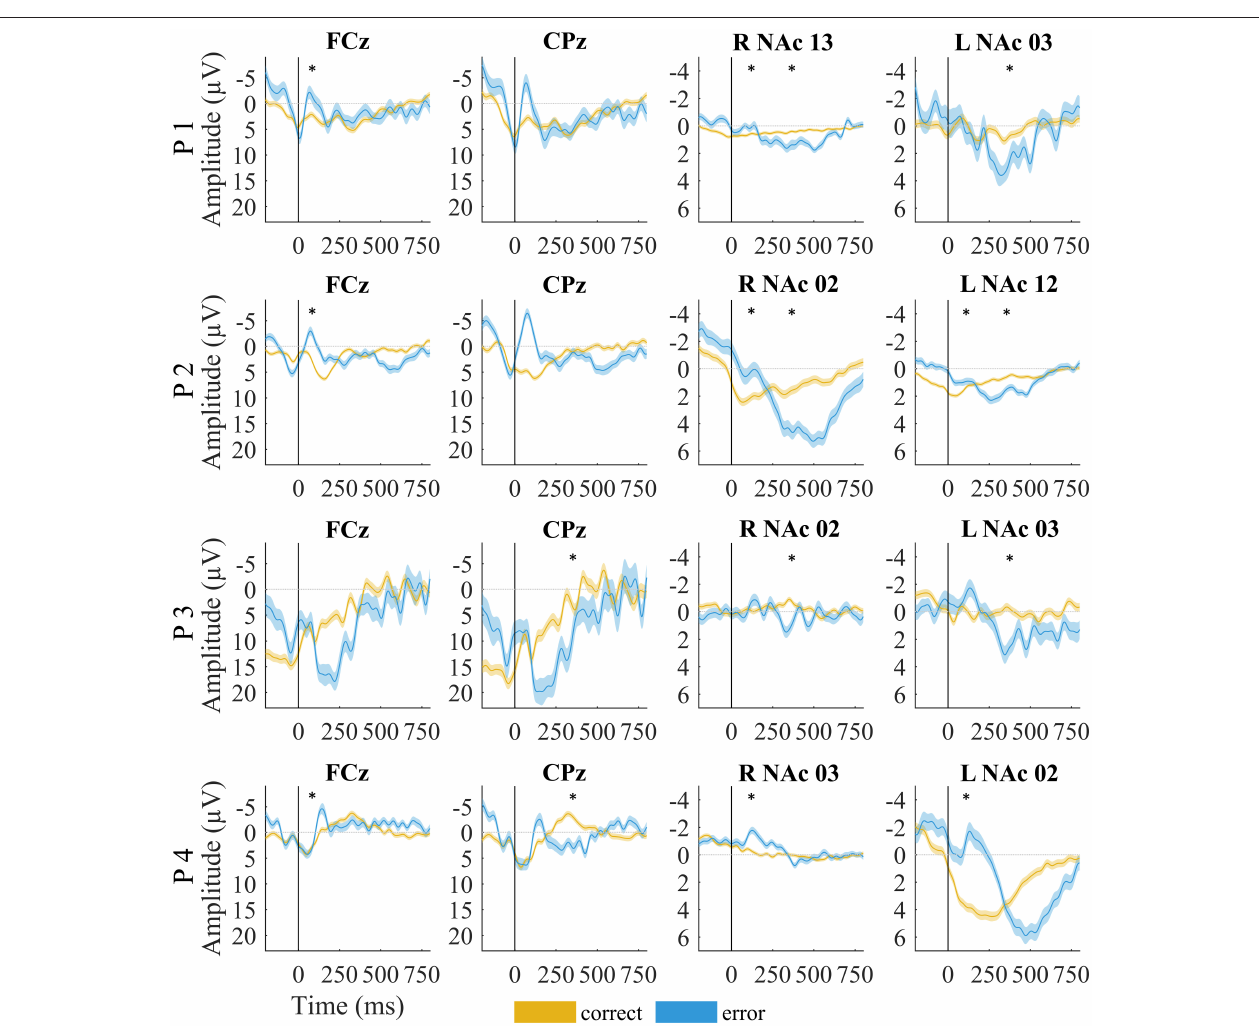
FIGURE 3 | EEG and local field potentials of patients for error (yellow) vs. correct (blue) trials. The shaded lines indicate standard error of the mean. Asterisks mark significant amplitude differences between error and correct trials at the time of the error-related negativity/correct-related negativity and error positivity. Data were filtered with a 20-Hz low-pass filter for